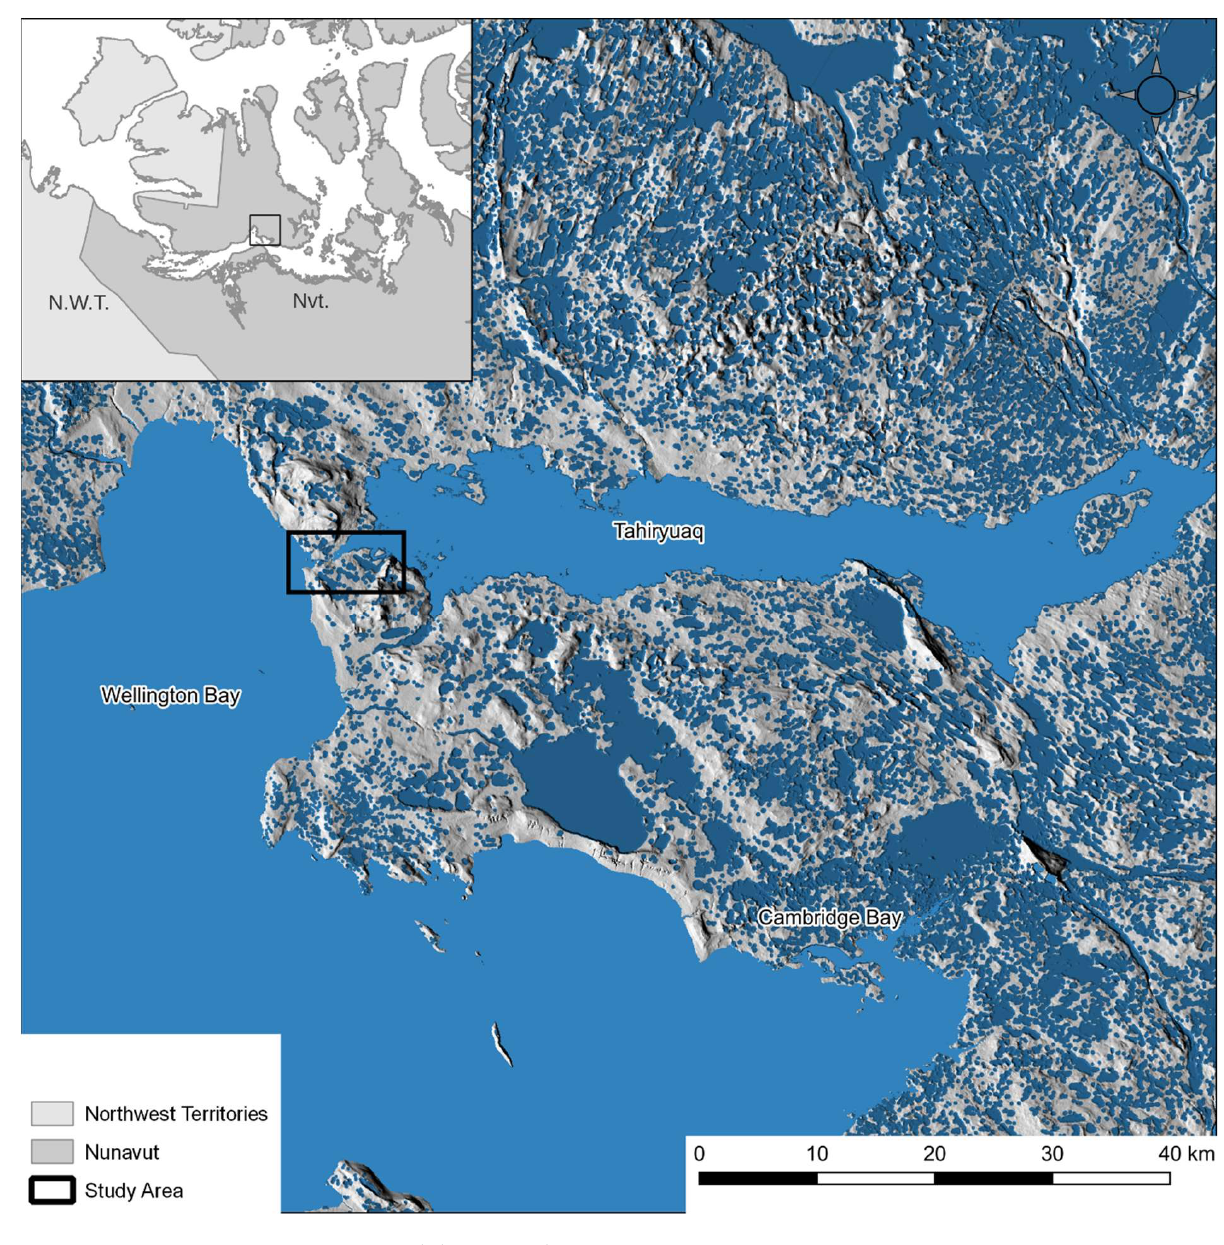
Figure 2. Iqaluktuuq Study Area.